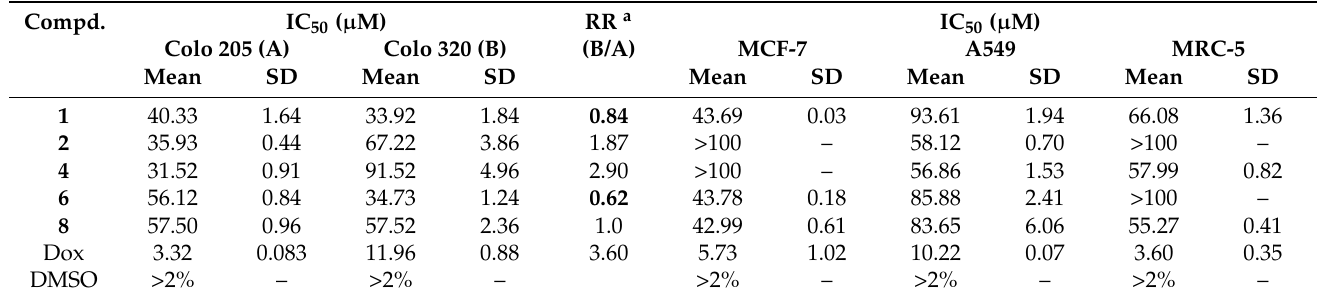
Table 4. Cytotoxic activity in human sensitive (Colo 205) and resistant (Colo 320) colon adenocarci- noma cells and relative resistance ratio of pholiols L, M, O, Q, and S ( 1 , 2 , 4 , 6 , and 8